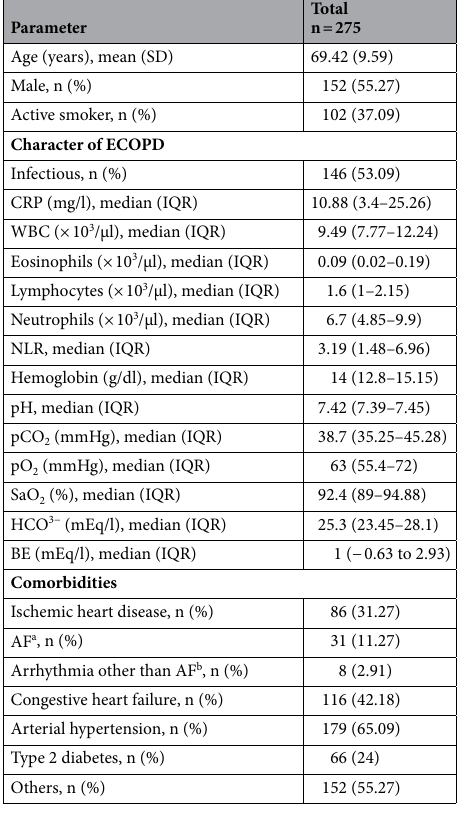
Table 1. Baseline study data. AF atrial fibrillation, CRP c-reactive protein, IQR interquartile range, WBC white blood count. a First detected in the admission, paroxysmal, persistent or permanent. b In the admission or in the past medical history.